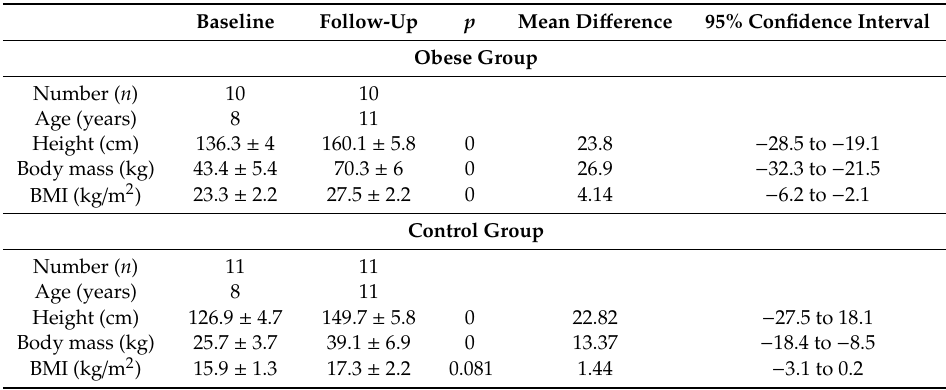
Table 1. Basic information of the